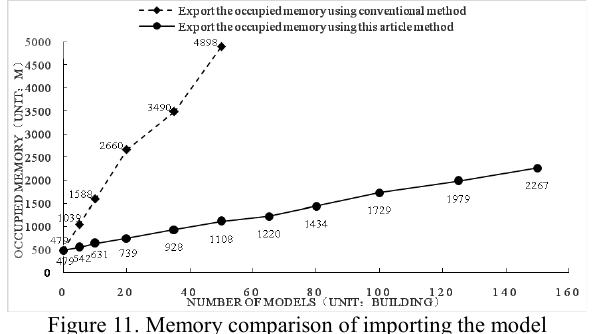
Figure 11. Memory comparison of importing the model generated by the two export methods into